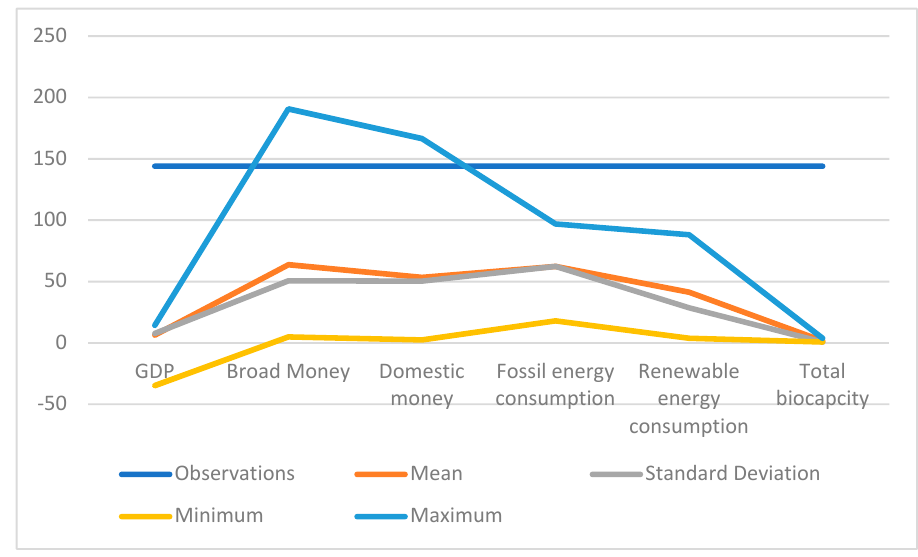
Figure 1. Data summary.